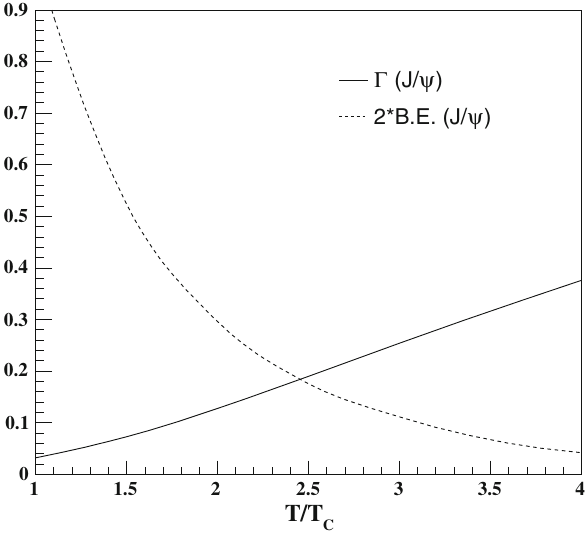
Fig. 16 Variation of two times of binding energy of J /ψ and decay width with respect to T / T C